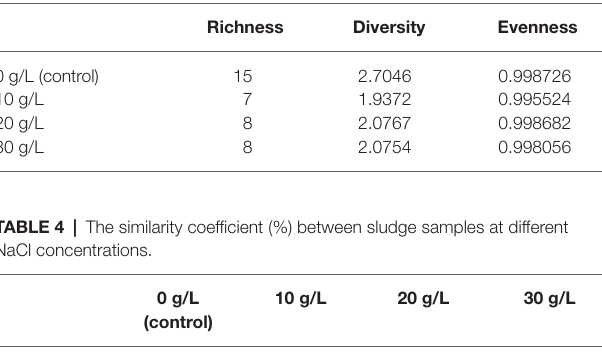
TABLE 3 | The richness, diversity, and evenness of microbial communities at different NaCl concentrations.